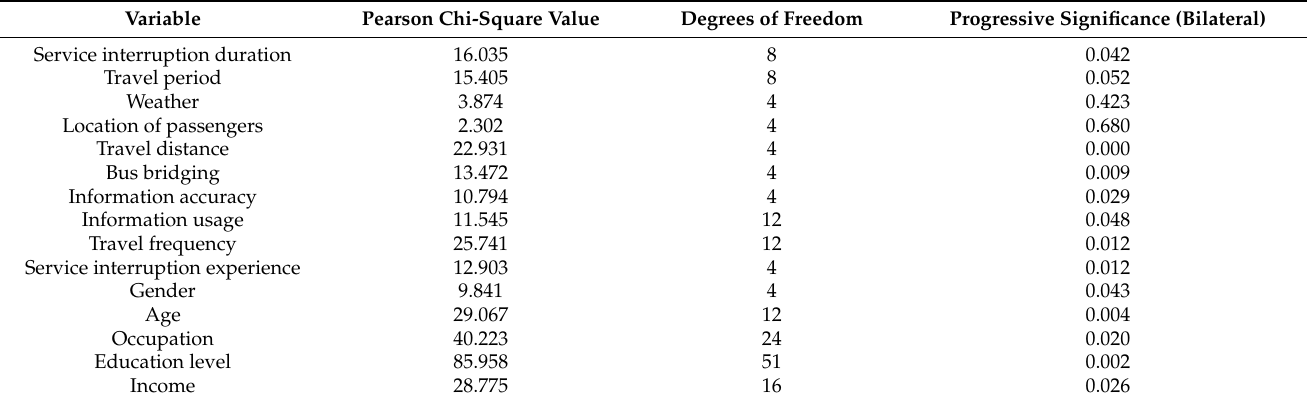
Table 8. Chi-square test of the